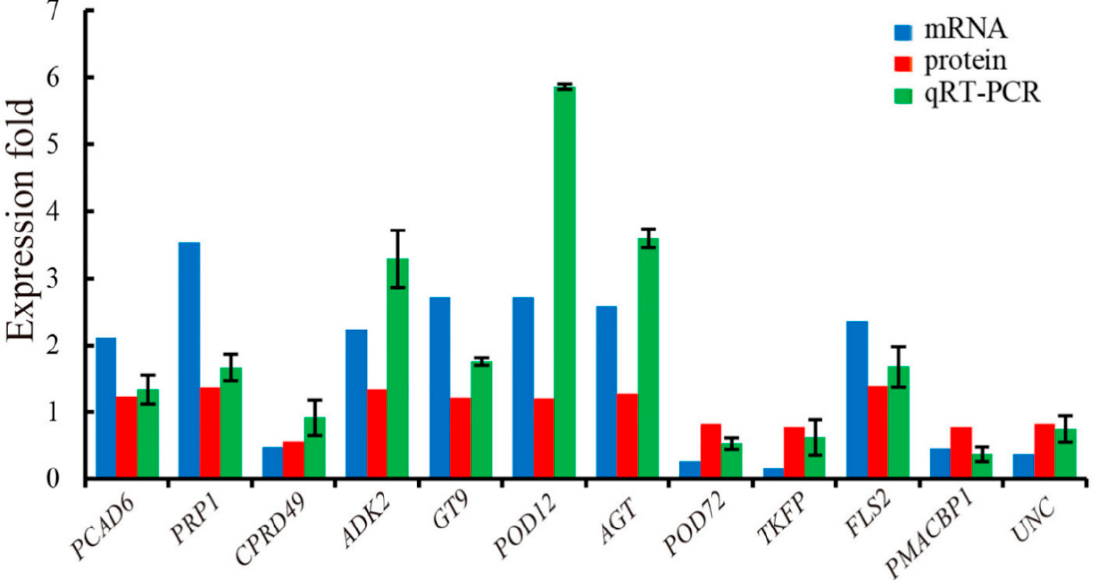
Figure 4. The relative expression of selected genes was verified by qRT-PCR. Abbreviations: PCAD6 —putative cinnamyl alcohol dehydrogenase 6; PRP1 —pathogenesis-related protein 1; CPRD49 —GDSL esterase/lipase CPRD49; ADK2 —adenosine kinase 2; GT9 —glutathione transferase 9; POD12 —peroxidase 12; AGT —anthocyanidin 3-O-glucosyltransferase; POD72 —peroxidase 72; TKFP —tyrosine kinase family protein; FLS2 —LRR receptor-like serine/threonine-protein kinase FLS2; PMACBP1 —plasma membrane-associated cation-binding protein 1; UNC —uncharacterized LOC100283518.